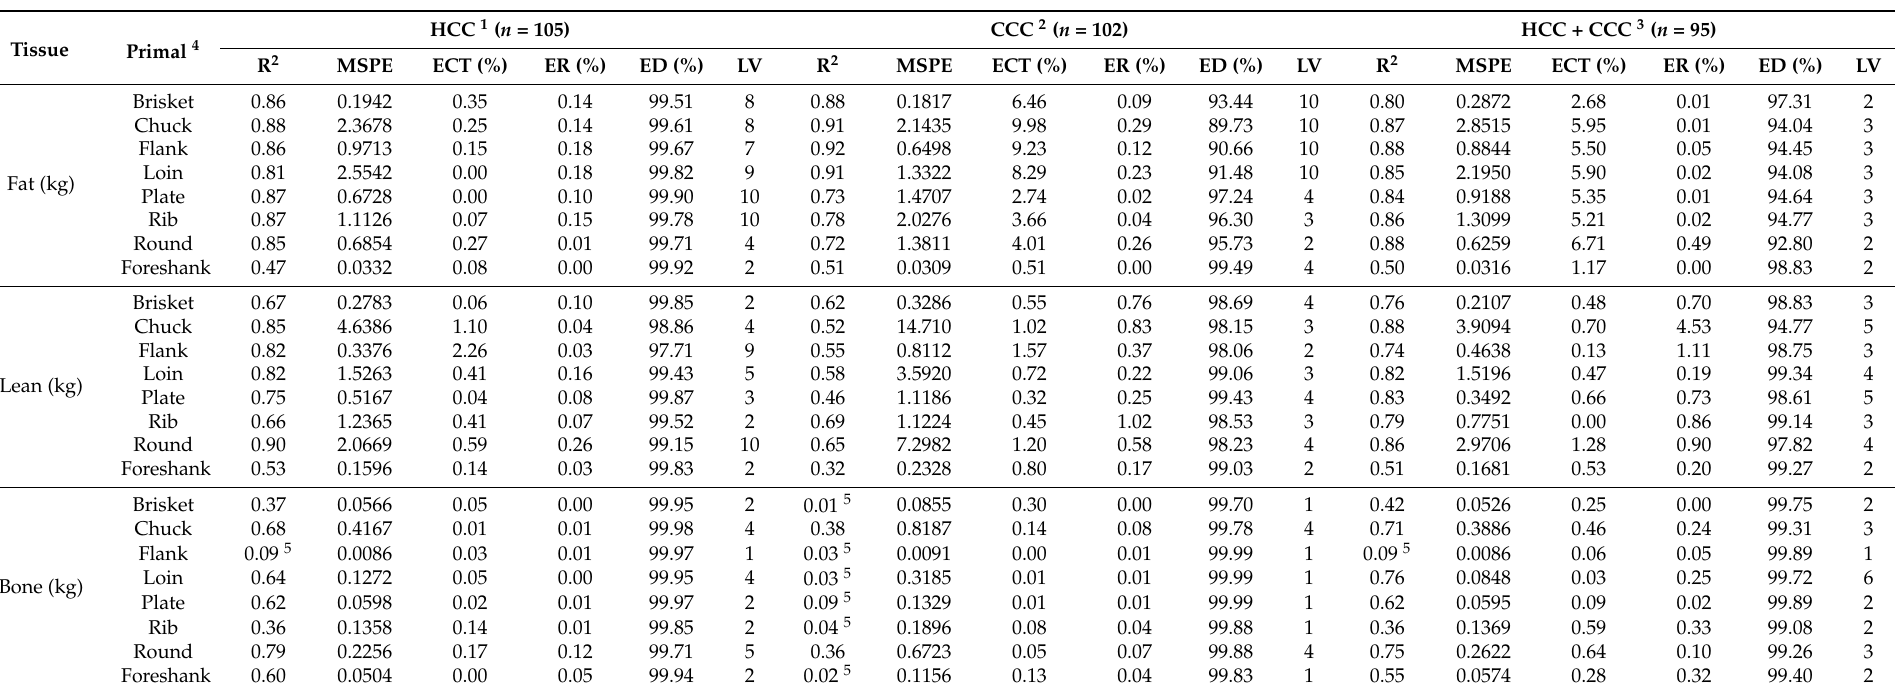
Table 2. Partial least square regression models estimating lean, fat, and bone for individual primal cuts from computer vision system (CVS) values. Coefficient of determination (R 2 ), mean square prediction error (MSPE), error in central tendency (ECT), error due to regression (ER), error due to disturbances (ED), and the number of latent variables (LV) are presented for each